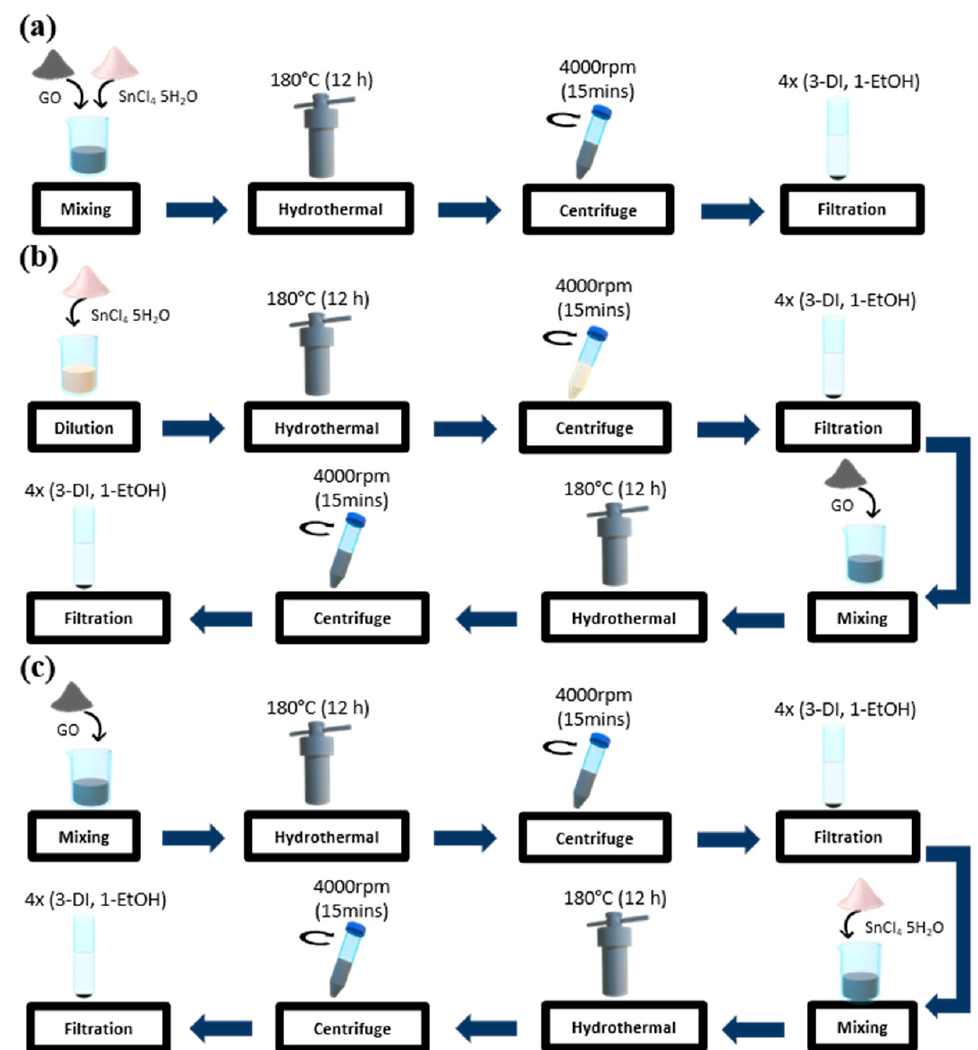
Figure 1. Schematic illustration of the preparation of three Sn 3 O 4 -RGO nanocomposites, ( a ) OS nano- composite ( b ) CO nanocomposite, ( c ) RS nanocomposite with different synthesis